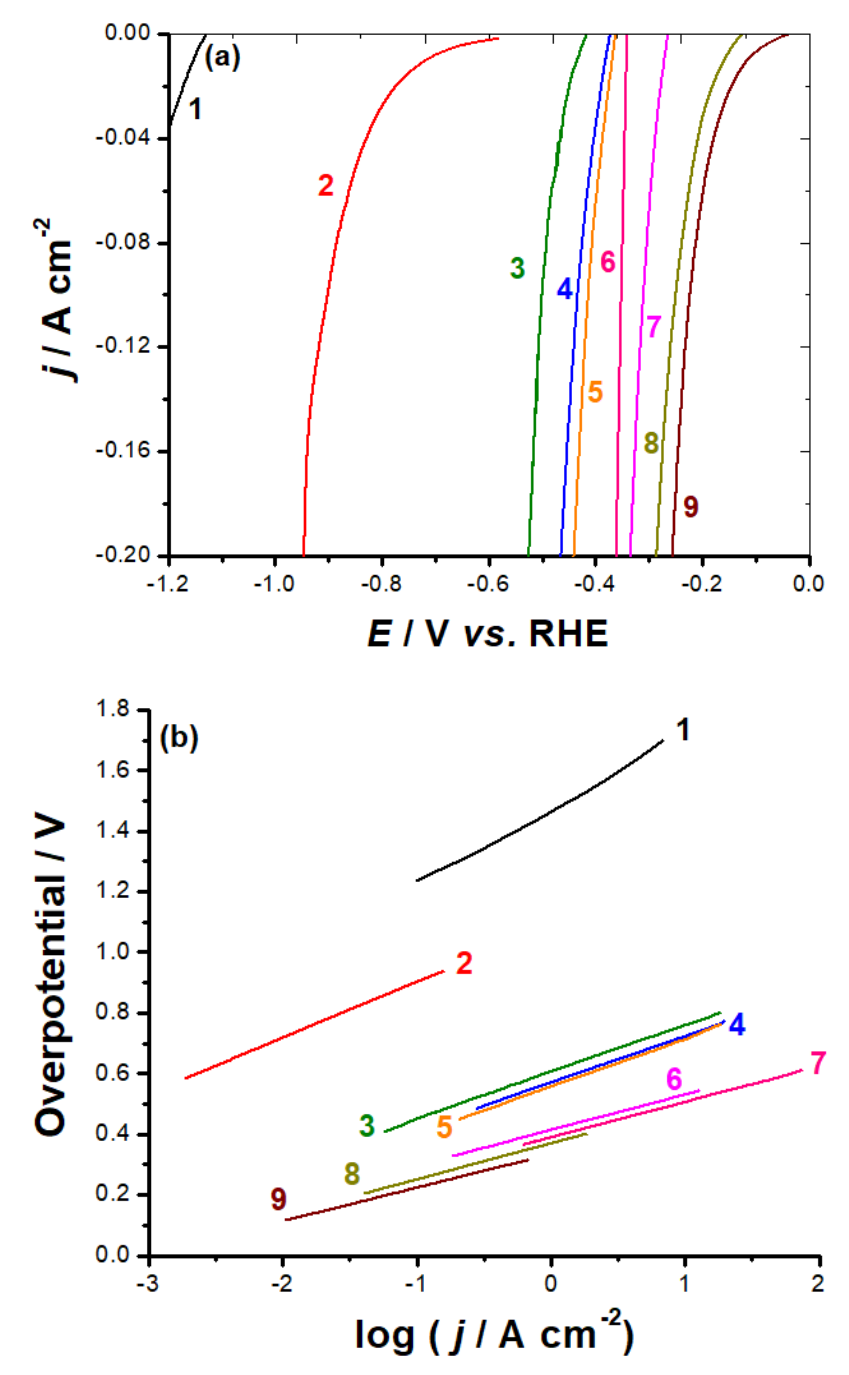
Figure 11. Cathodic polarization curves ( a ) and their corresponding Tafel plots ( b ) recorded for the investigated Zn3 of various loading densities (unsupported and supported on GO) in a comparison with the supporting material (GO). Measurements were conducted in 0.1 M KOH aqueous solution at a scan rate of 5 mV s − 1 at room temperature. (1) Bare GC electrode; (2) GC − GO; (3) GC − Zn3 (0.2 mg cm − 2 ); (4) GC − Zn3 (0.4 mg cm − 2 ); (5) GC − Zn3 (0.8 mg cm − 2 ); (6) GC − Zn3 (0.2 mg cm − 2 )/GO; (7)